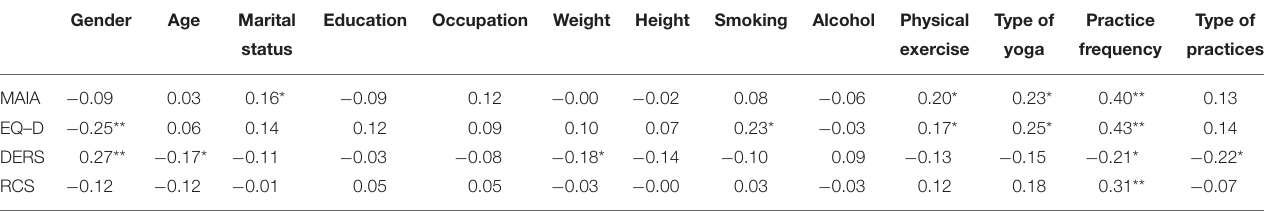
TABLE 5 | Bivariate correlations of the outcome variables with sociodemographic characteristics, life habits, and aspects of yoga practice in the Spanish participants.